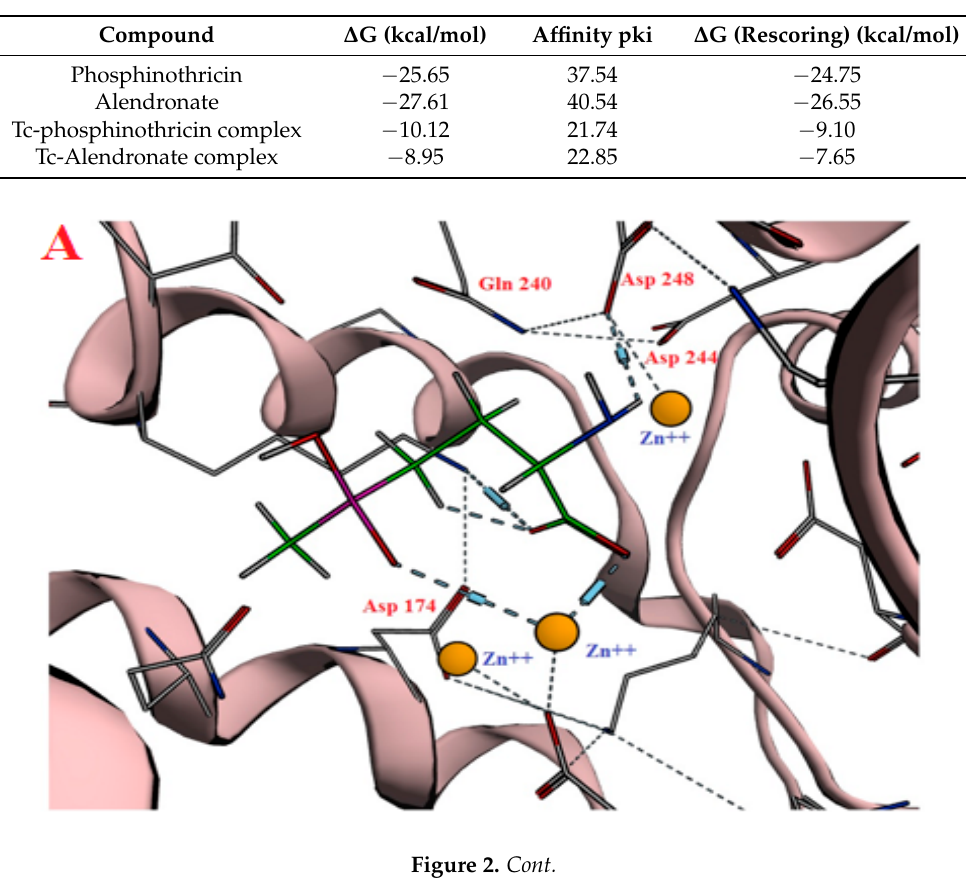
Table 1. Molecular docking results using MOE.